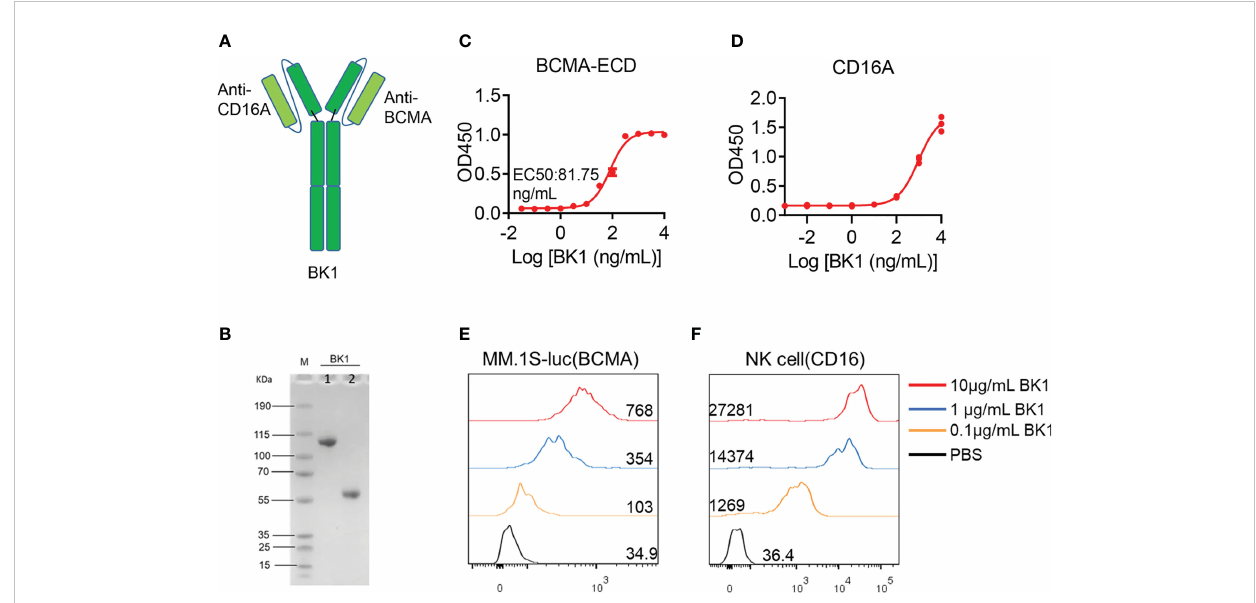
FIGURE 1 Structural features and binding af fi nity of BK1 (BCMA×CD16A) bispeci fi c antibody. (A) Schematic representation of BK1 (CD16A×BCMA), a two-arm IgG1-based human antibody. (B) The molecular weight and purity of BK1 were determined by SDS-PAGE. M: protein marker, 1: Nonreducing electrophoresis, 2: reducing electrophoresis. (C) Binding speci fi city of BK1 with the BCMA extracellular domain protein. (D) Binding speci fi city of BK1 with CD16A protein. (E) Binding speci fi city of BK1 with BCMA + MM.1S-luc cells. BK1 was labeled with Alexa Fluor 647 fl uorescein and incubated with BCMA + MM.1S-luc cells at 10 m g/mL, 1 m g/mL and 0.1 m g/mL, respectively, followed by fl ow cytometric analysis. (F) Binding speci fi city of BK1 with CD16 + NK cells. BK1 was labeled with Alexa Fluor 647 fl uorescein and incubated with CD16 + NK cells at 10 m g/mL, 1 m g/mL and 0.1 m g/mL, followed by fl ow cytometric analysis. (C-F) Data are representative of at least three independent